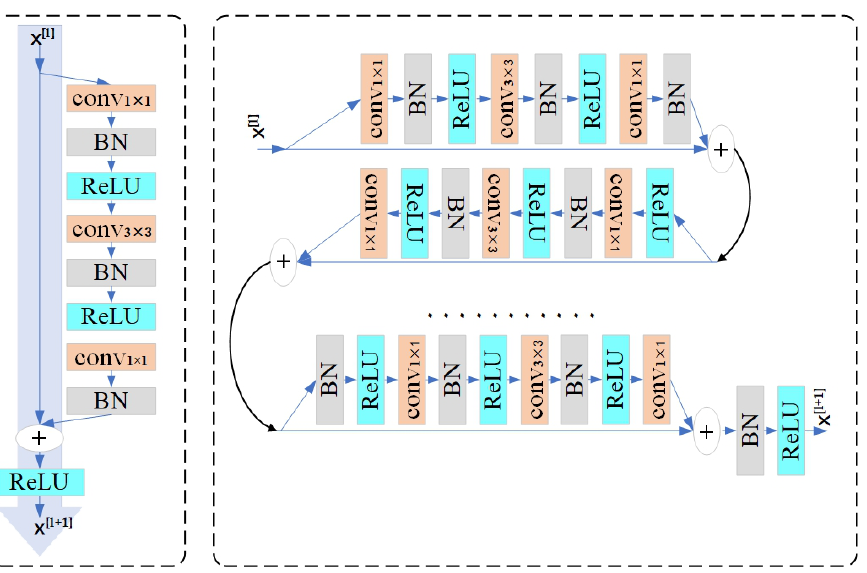
Figure 2. The construction of the improved ResBlock. The box on the left is the ResBlock of ResNet, and on the right is our structure.